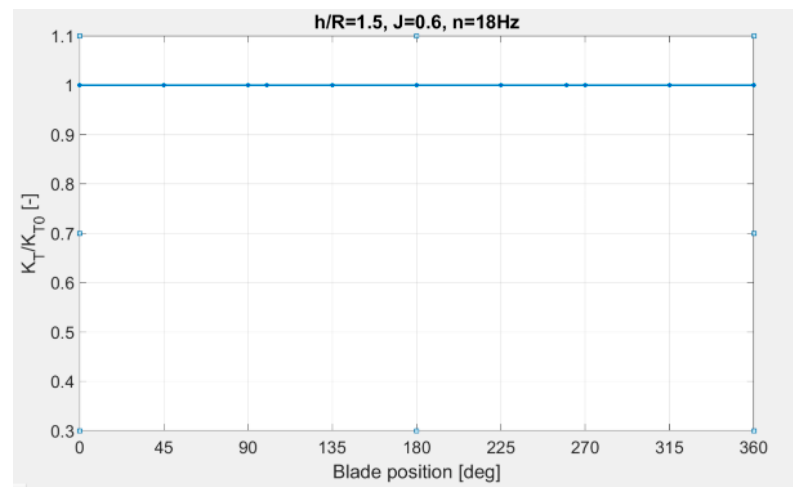
Figure 14. Calculation of thrust loss factor as a function of blade position.